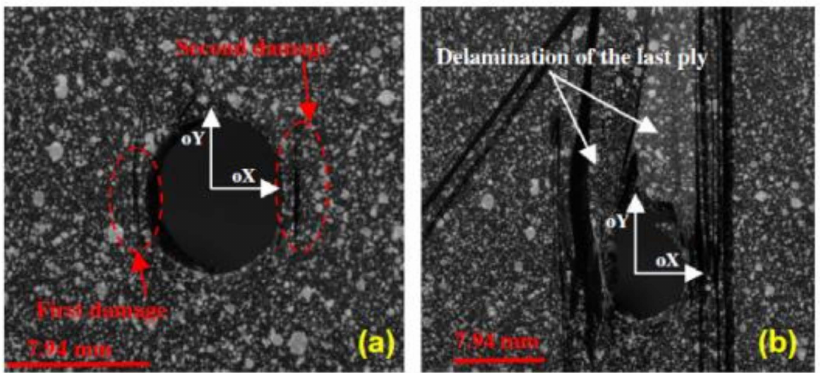
Figure 26. Damage progression for di ff erent loading levels for 7.94 mm moulded hole in OHT test for